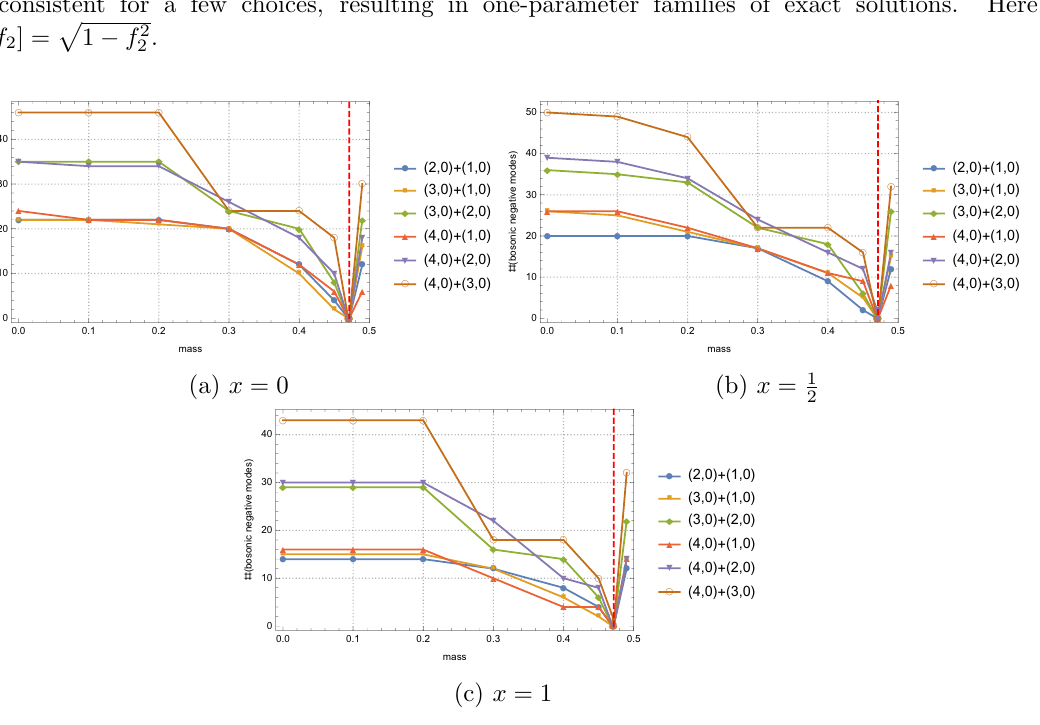
Figure 30. C [( N 1 ; 0)] + C [( N 2 ; 0)] + D with Higgs con(cid:12)guration (B.19). The number of negative modes for O X + (cid:30) , for each choice of mass value M , are depicted in (a){(c). The red dashed vertical p V lines indicates the mass value M = 2 =